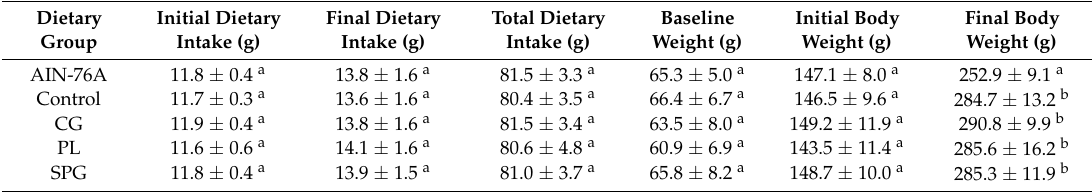
Table 3. SHR dietary intake and body weight.